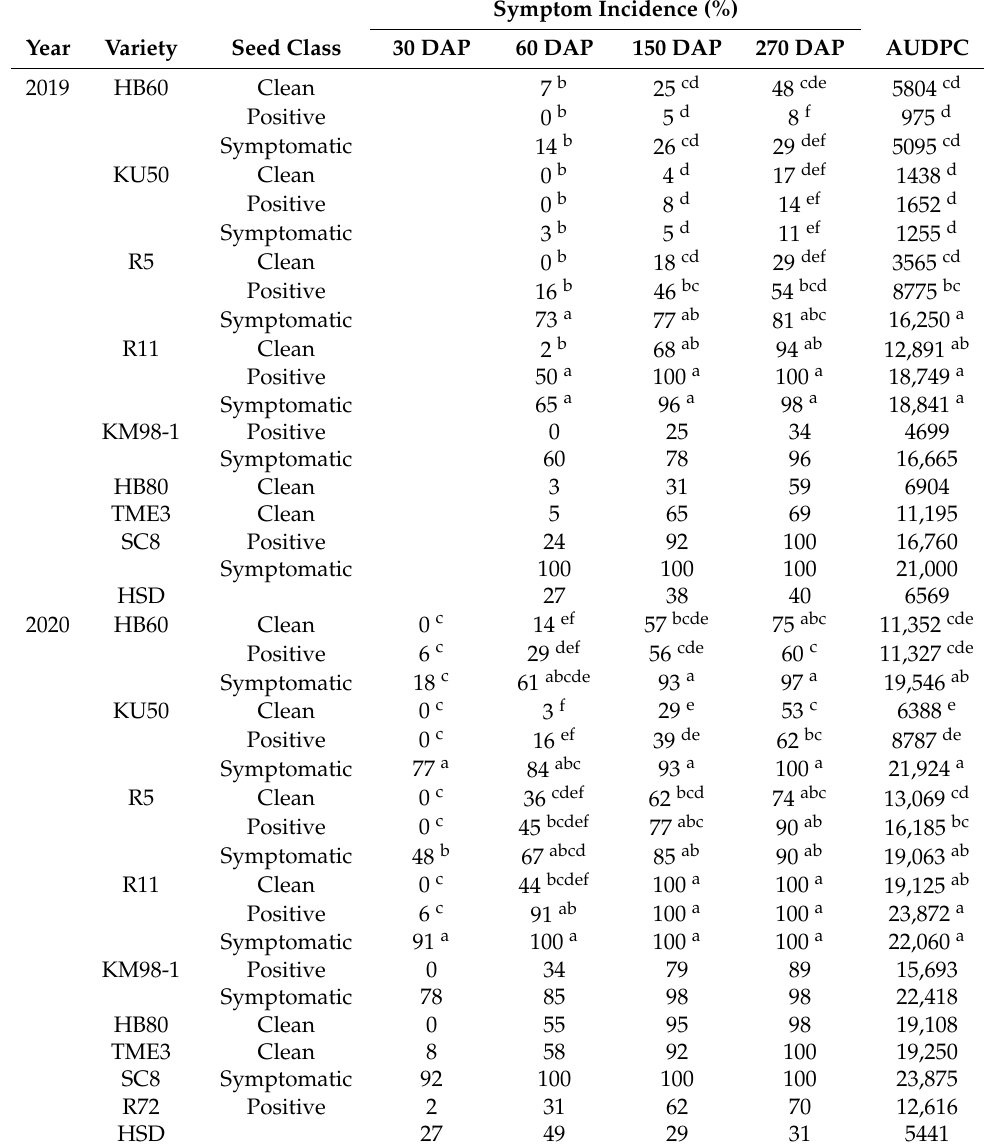
Table 3. Percentage of symptomatic plants (%) per plot and area under disease progress curves (AUDPC) of four cassava varieties and three seed classes at four different DAP (days after planting) intervals in the 2019–2020 and 2020–2021 seasons. Group means followed by different letters within a year column (a to f) are significantly different (Tukey’s HSD); those not followed by a letter were part of incomplete treatment combinations and were not included in statistical analyses of variance but are reported for